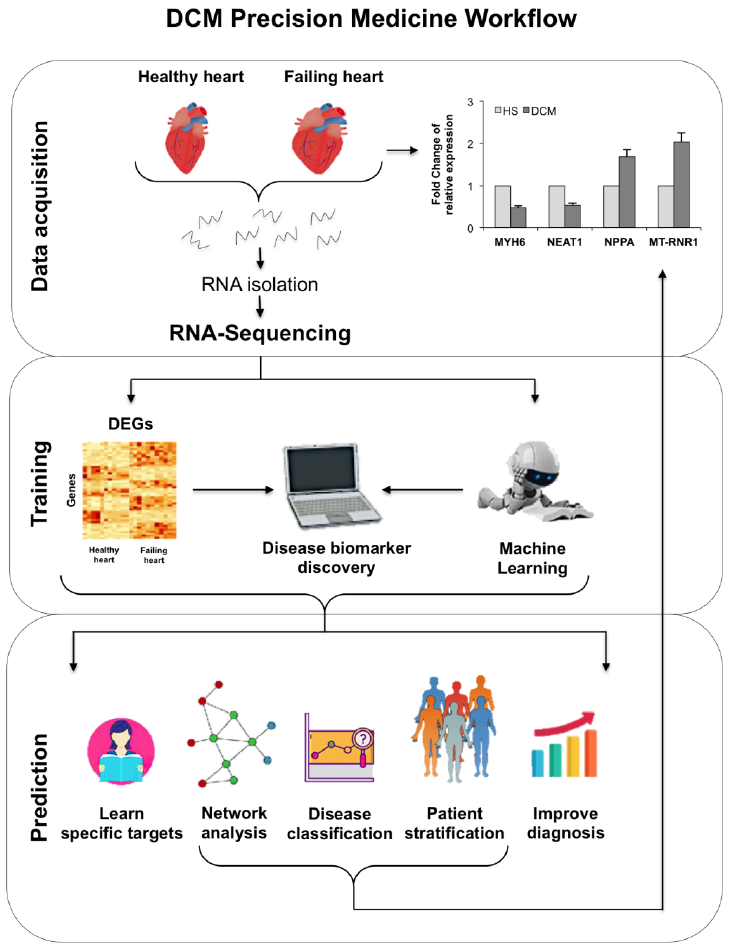
Figure 7. DCM Precision Medicine WorkflowAll p -value-filtered DEGs (443) inferred on NPPA protein coding gene, which was correlated with echocardiographic parameters, was used to perform Protein-Protein Interaction network. The picture shows String analysis.